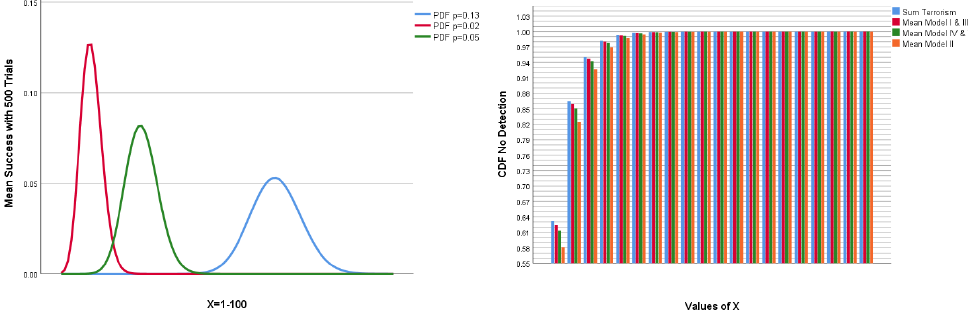
Figure 15. The figure on the left shows a binomial probability density function (PDF) for the p-values of the five models. Number of trials is 500. X starts at 1 and ends at 100. The figure on the right shows an exponential cumulative distribution function (CDF) plots no detection based on the respective probabilities: Model I–V (0.02–0.13) and terrorism ( 1.1 × 10 − 6 ) (X =